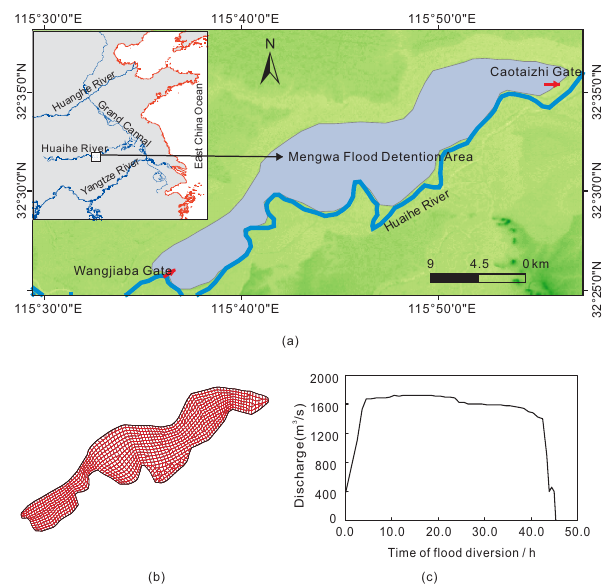
Figure 8. (a) Mengwa flood detention area (MFDA); (b) unstruc- tured grid; (c) inflow discharge hydrograph.